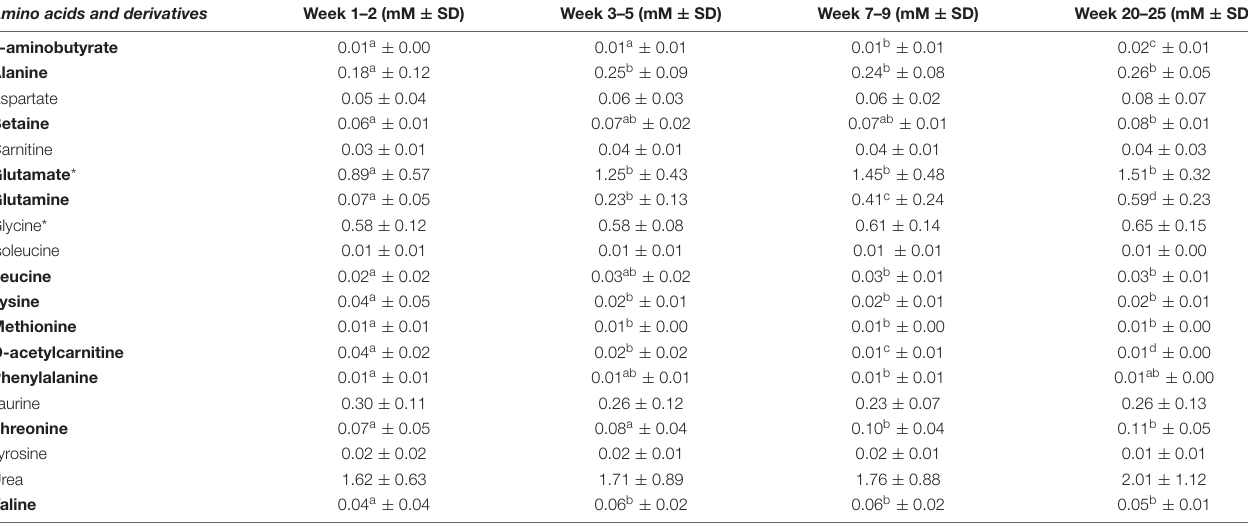
TABLE 3 | Mean levels (in mM ± standard deviation) of amino acids and their derivatives in human milk from term deliveries sampled weeks 1–2, 3–5, 7–9, and 20–25 postpartum.